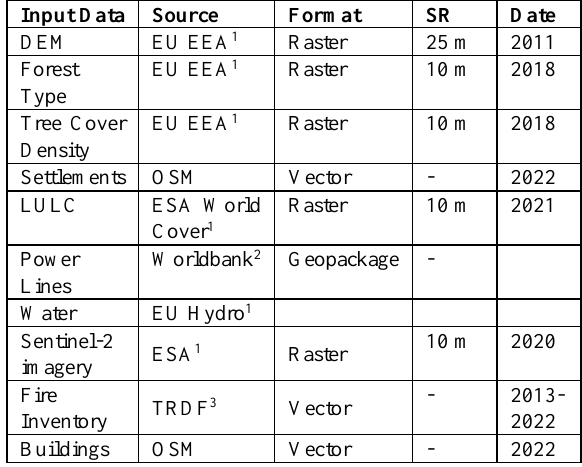
Table 1 . Input data characteristics.